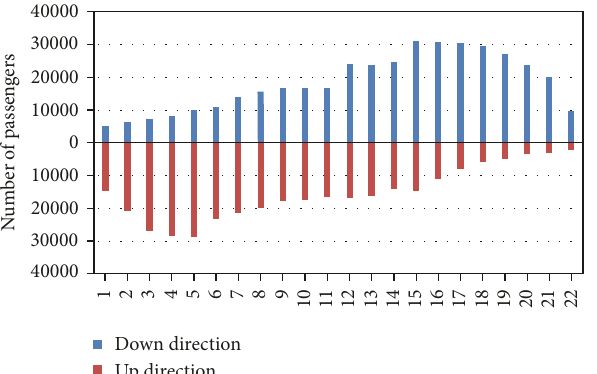
Figure 12: Number of passengers on the train in different intersta- tions.